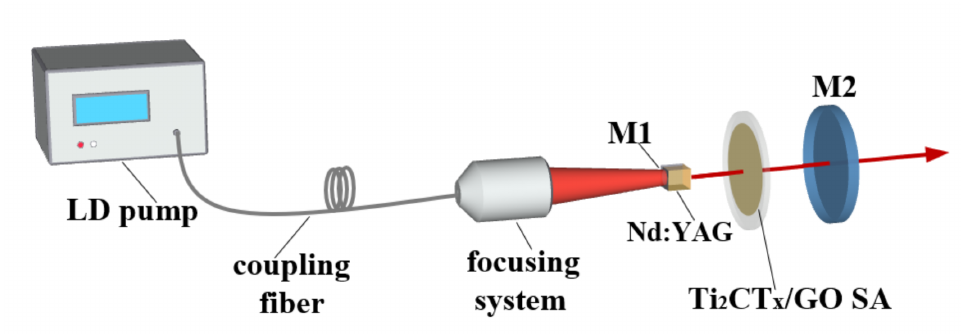
Figure 8. Schematic of the passively Q-switched Nd:YAG laser with a Ti 2 CT x -GO saturable ab- sorber